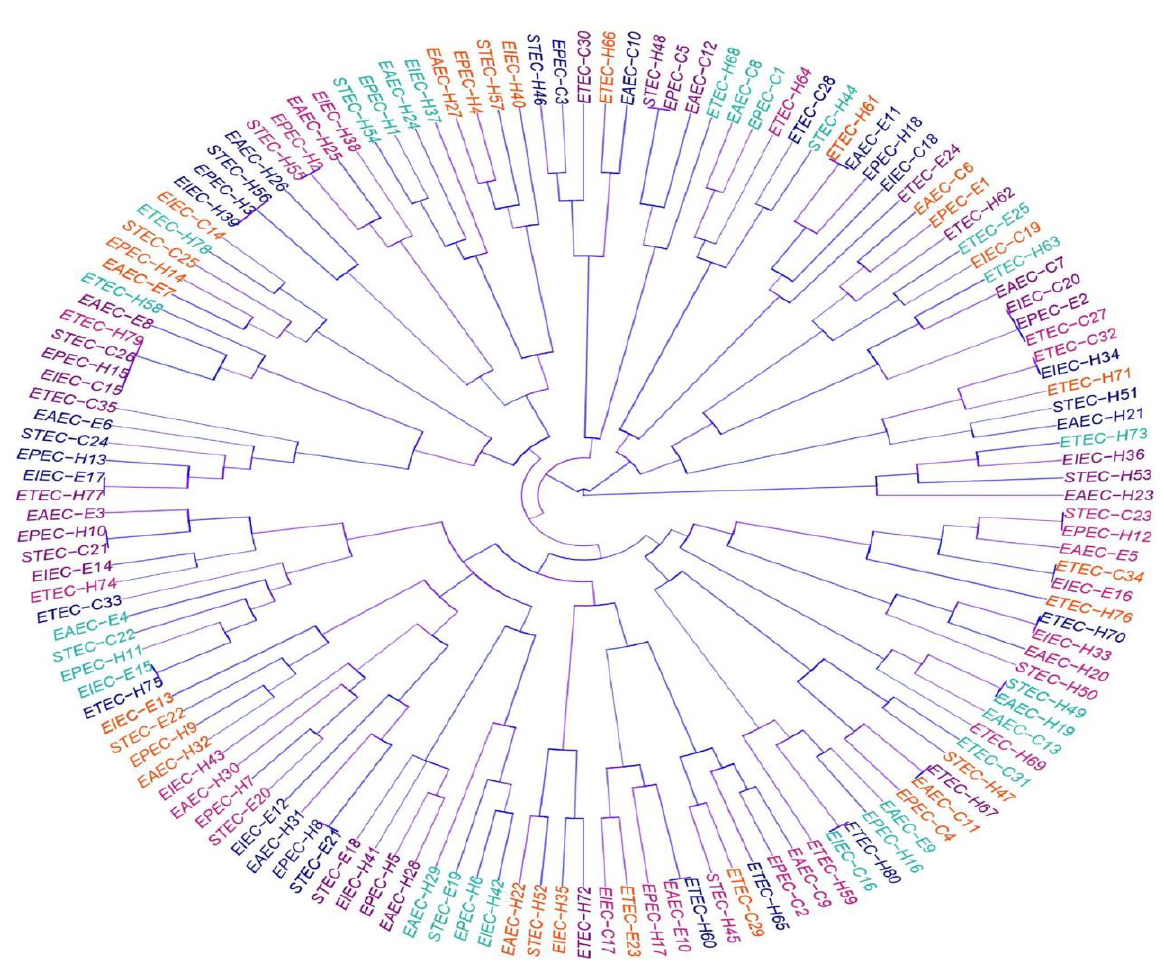
Figure 5. Dendrogram showing the relatedness of diarrheagenic E. coli pathotypes isolated from equine (E), cow (C), and human (H) origins, as determined by ERIC-PCR fingerprinting. EAEC: enteroaggregative E. coli , ETEC: enterotoxigenic E. coli , EPEC: enteropathogenic E. coli , EIEC: enteroinvasive E. coli , STEC: shiga-toxin-producing E. coli .